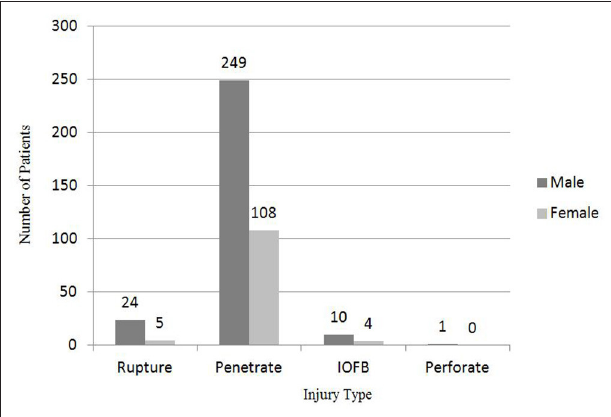
FIGURE 3 | Sex and injury type distribution of OGI in children.